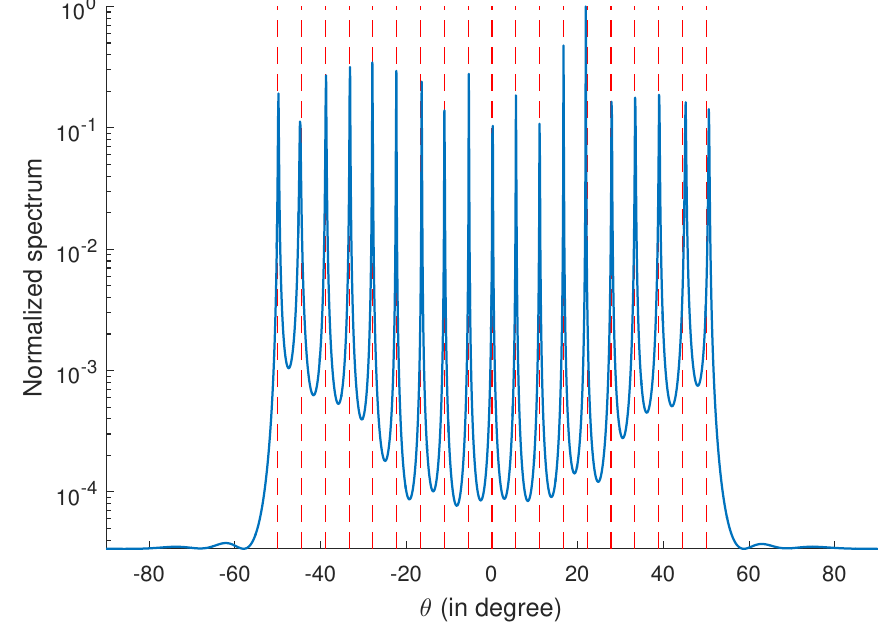
Figure 1. DOA estimation using the proposed algorithm. Red dashed lines are the true DOAs. Q = 19 sources distributed uniformly from [ − 50 ◦ ,50 ◦ ] impinge on the coprime array. The signal-to-noise ratio (SNR) is 0 dB, the number of snapshots is 500, and (cid:101) is set as